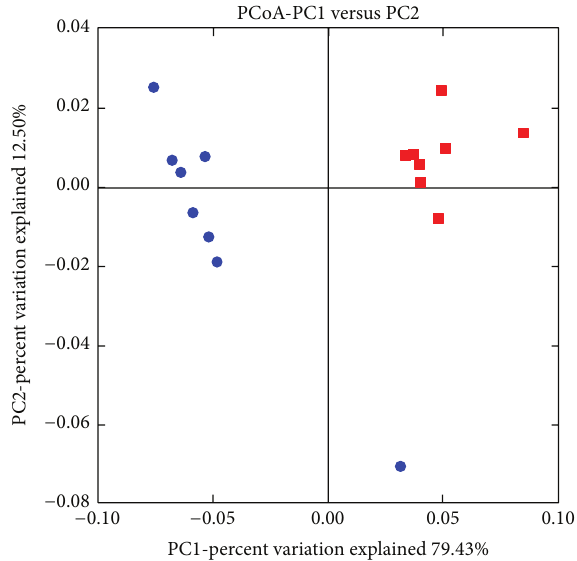
Figure 2: Principal component analysis of rumen methanogenic archaea profiles in does: blue circles = D+ and red square = D − .